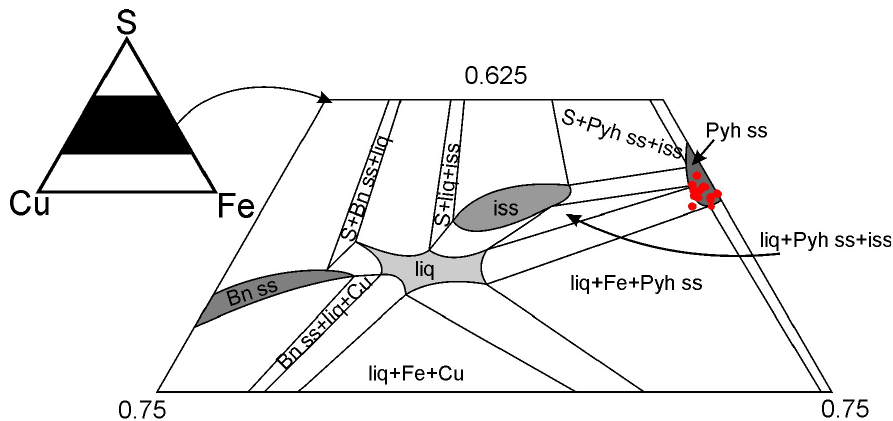
Figure 23. Composition of homogenized sulfide melt inclusions (red dots) on the phase diagram of the Cu-Fe-S system at 800 °C [81]. Abbreviations: Bn, bornite; Pyh, pyrrhotite; ss, solid solution; iss, intermediate solid solution; and liq, liqua.